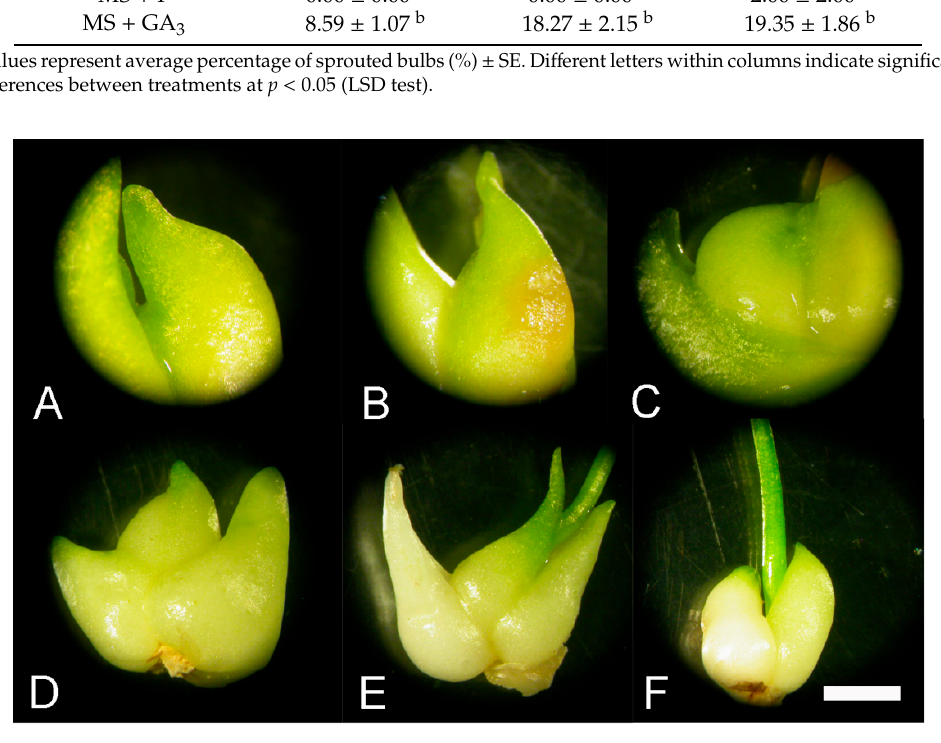
Figure 1. Sprouting of bulbs cultured F. meleagris bulbs cultured on medium with 10 µ M GA 3 and GA inhibitors. ( A , B ) Bulbs grown for five weeks at 24 ◦ C on culture medium supplemented with GA 3 inhibitors: ancymidol ( A ) and paclobutrazol ( B ). ( C ) Bulb grown for five weeks at 7 ◦ C on culture medium supplemented with and GA 3 . ( D - F ) Bulbs cultured on medium with GA 3 after one ( D ), two ( E ) and five weeks ( F ) at 24 ◦ C. Scale bars = 5 mm.